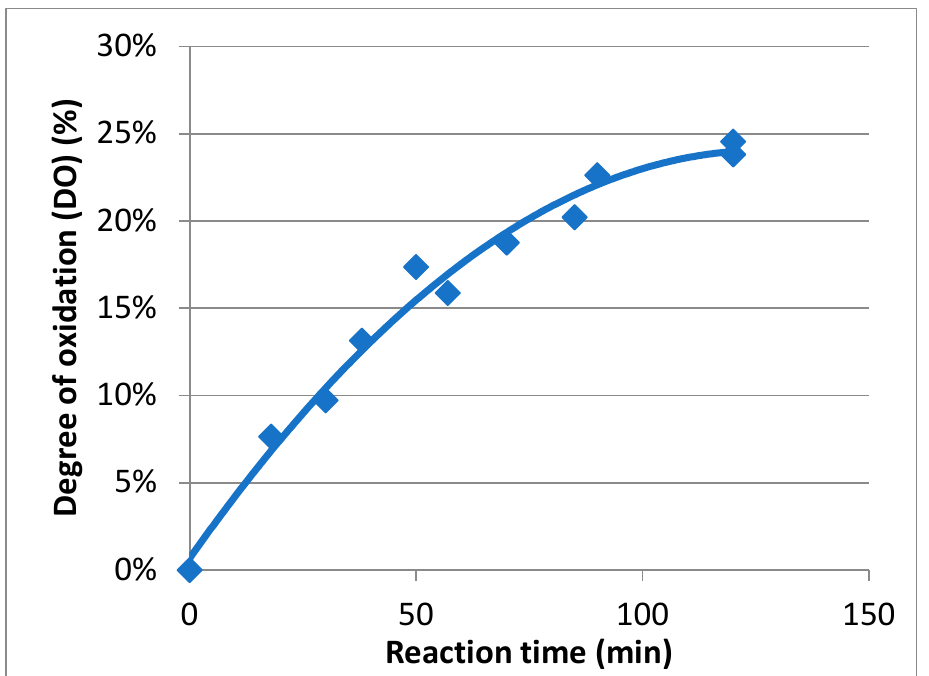
Figure 4. Kinetic study of the oxidation of mannan.